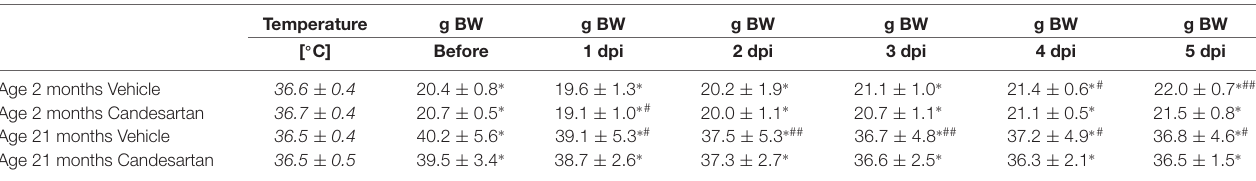
TABLE 3 | Intraoperative body temperature and pre- and postoperative body